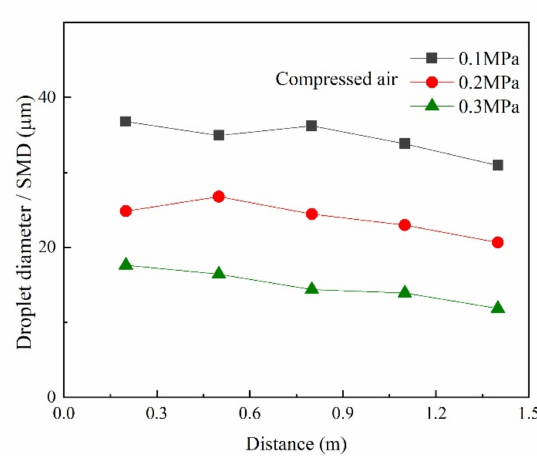
Figure 13. Effect of compressed air pressure on SMD (Q = 10 L/h, T = 70 °C).